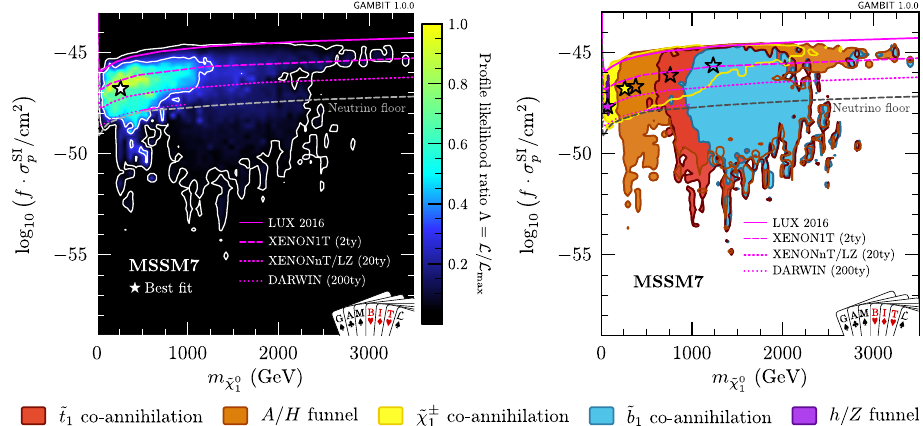
Fig. 12 Spin-independent neutralino-proton scattering cross-sections in the MSSM7, rescaled by the fraction f of the observed relic den- sity predicted by each model. Left: profile likelihood, showing 68 and 95% CL contours. Right: colour-coding shows mechanism(s) that allow models within the 95% CL region of the profile likelihood to avoid exceeding the observed relic density of DM, corresponding to neu- tralino co-annihilation with charginos, stops or sbottoms, and resonant annihilation through the light or heavy Higgs funnels. Overplotted are